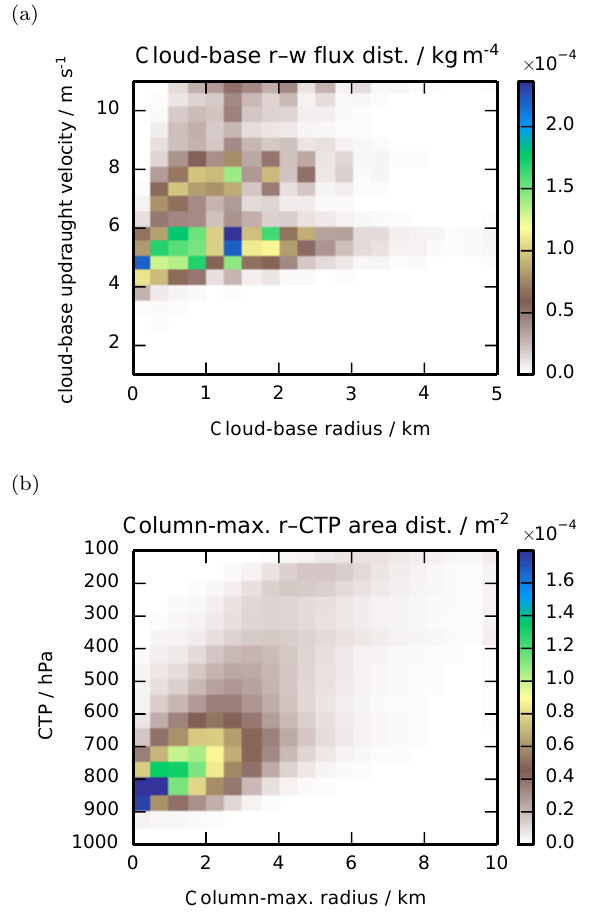
Figure 11. Joint distributions of (a) cloud-base radius and up- draught velocity, and (b) column-maximum updraught radius and cloud-top pressure from a 30-year AMIP-type simulations using ECHAM–HAM with CCFM (L −